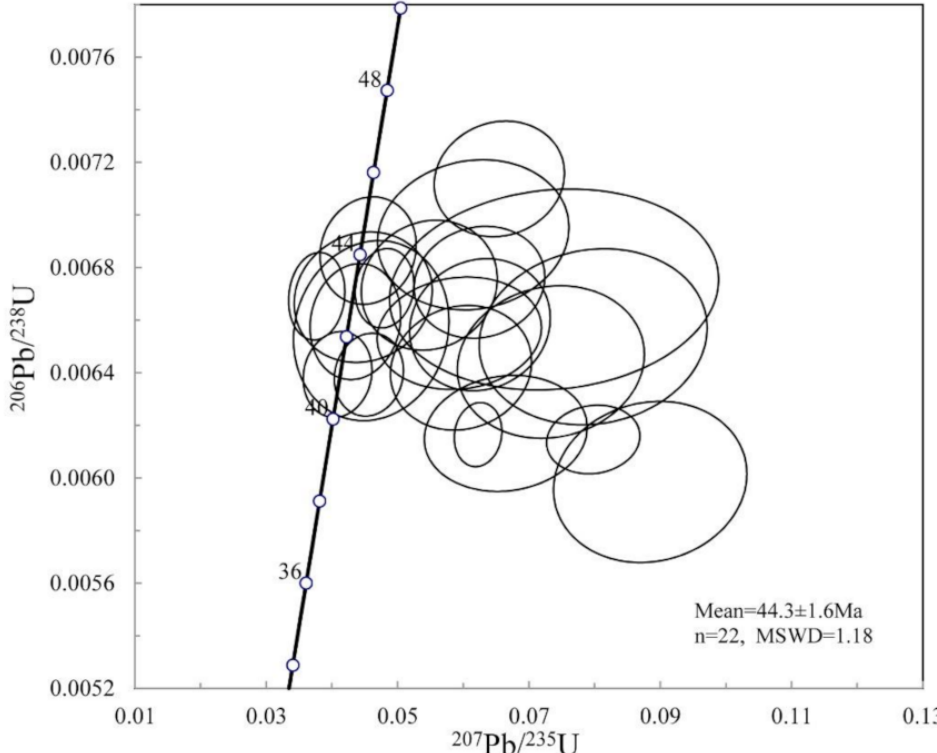
Figure 11. LA-ICP-MS zircon U–Pb Concordia diagrams for the investigated dykes from the NW of